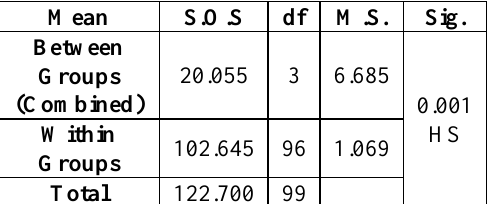
Table 6: ANOVA test Results of Mean Bennett